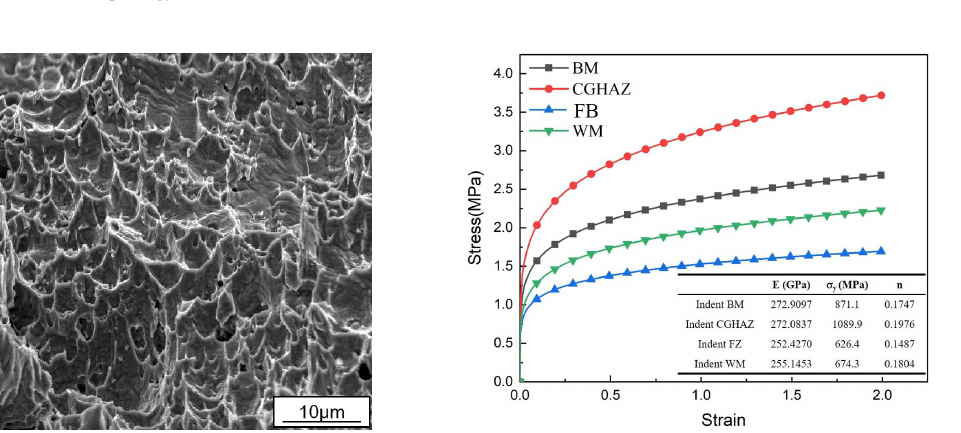
Figure 11. SEM fracture morphology of each micro área.